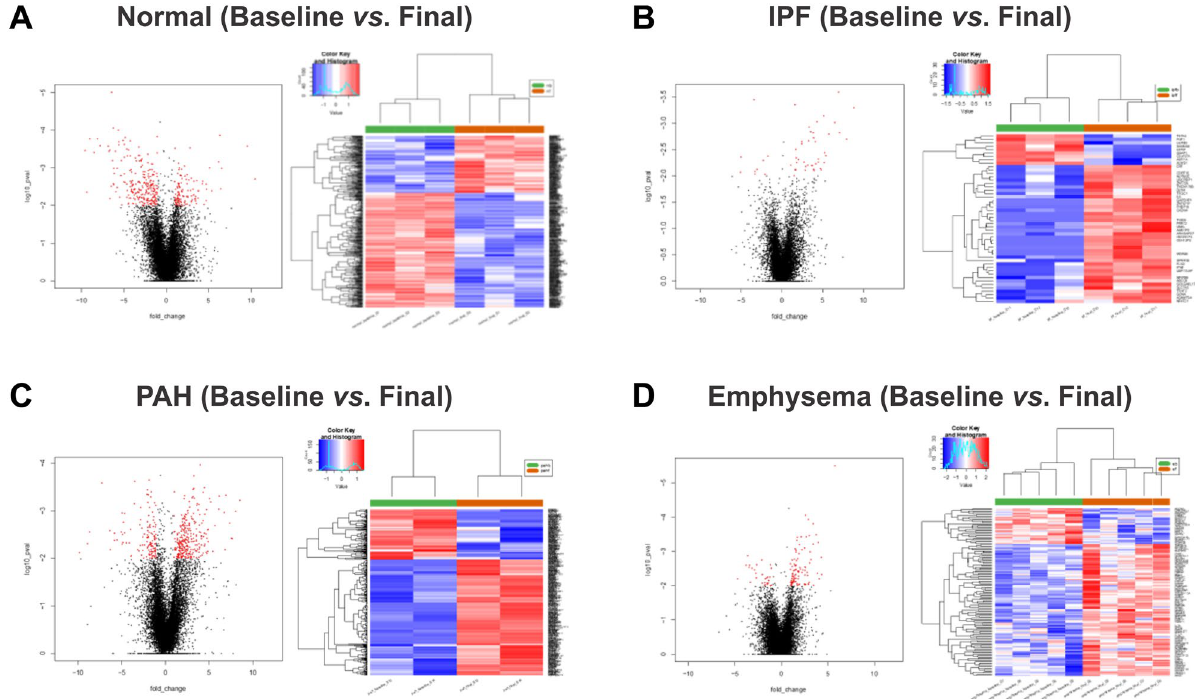
Figure 6. Heatmap and volcano plots of differentially expressed genes before (green) and after EVLP (orange) in normal ( A ), IPF ( B ), PAH ( C ), and Emphysema ( D ). Raw p value < 0.01 and |logFC|>